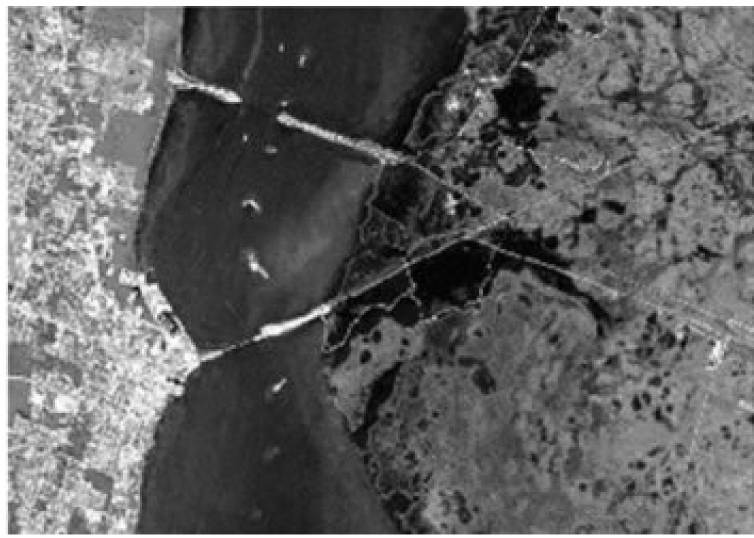
Figure 4. Sample band of P Kennedy Space Center